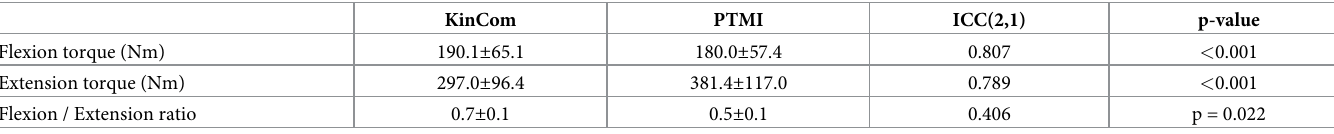
Table 1. Correlation coefficients for trunk muscle between by KinCom and PTMI in study